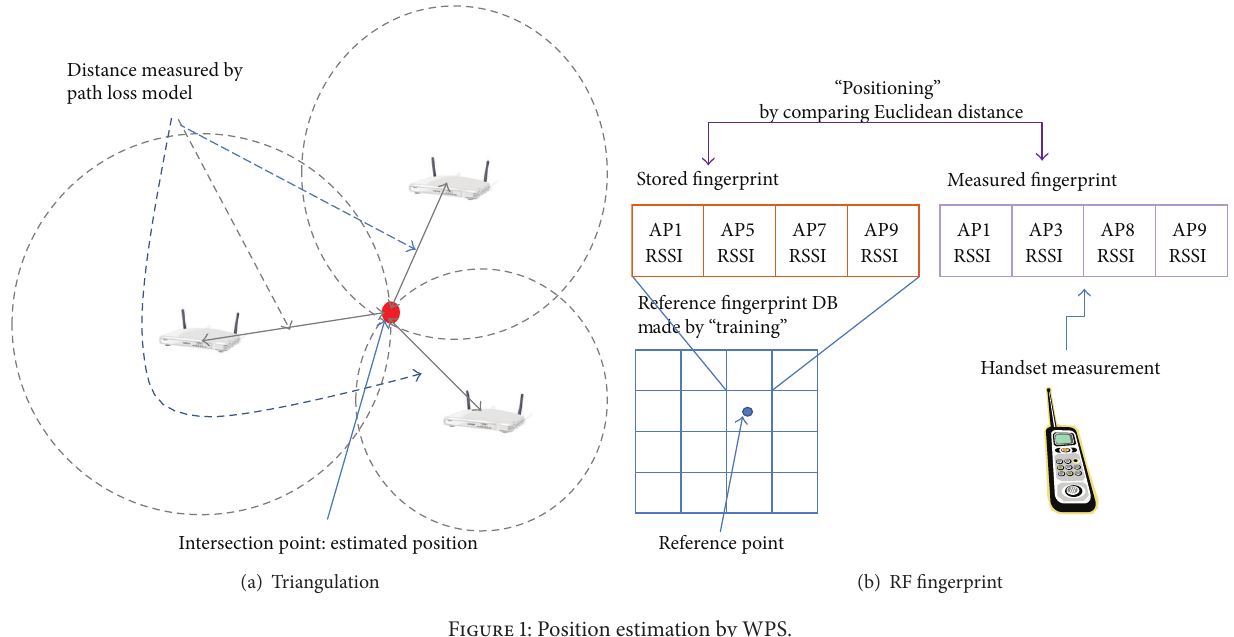
Figure 1: Position estimation by